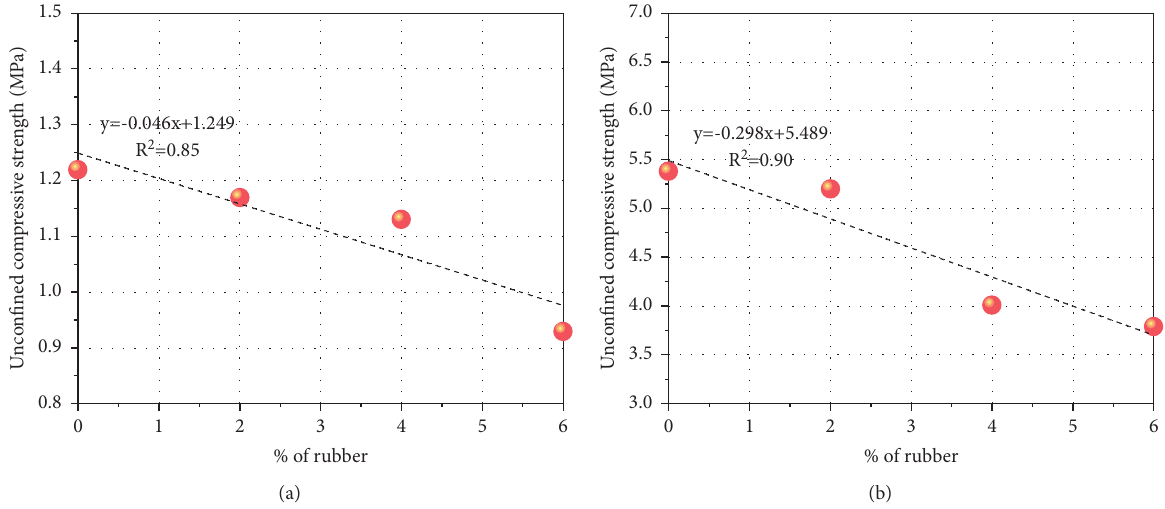
Figure 5: Relationship between the unconfined compressive strength and rubber content of cemented tailings: (a) 10% cement content samples and (b) 25% cement content